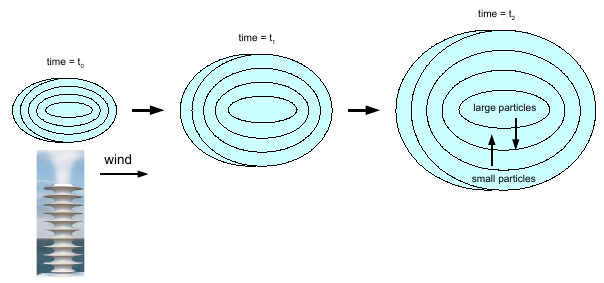
Fig. 1. Schematic of the Gaussian plume model. The shells expand with time due to dilution. Coagulation proceeds more quickly in the inner shells, due to higher particle concentrations, and thus there is a net flux of small particles to the inner shells and large particles to the outer